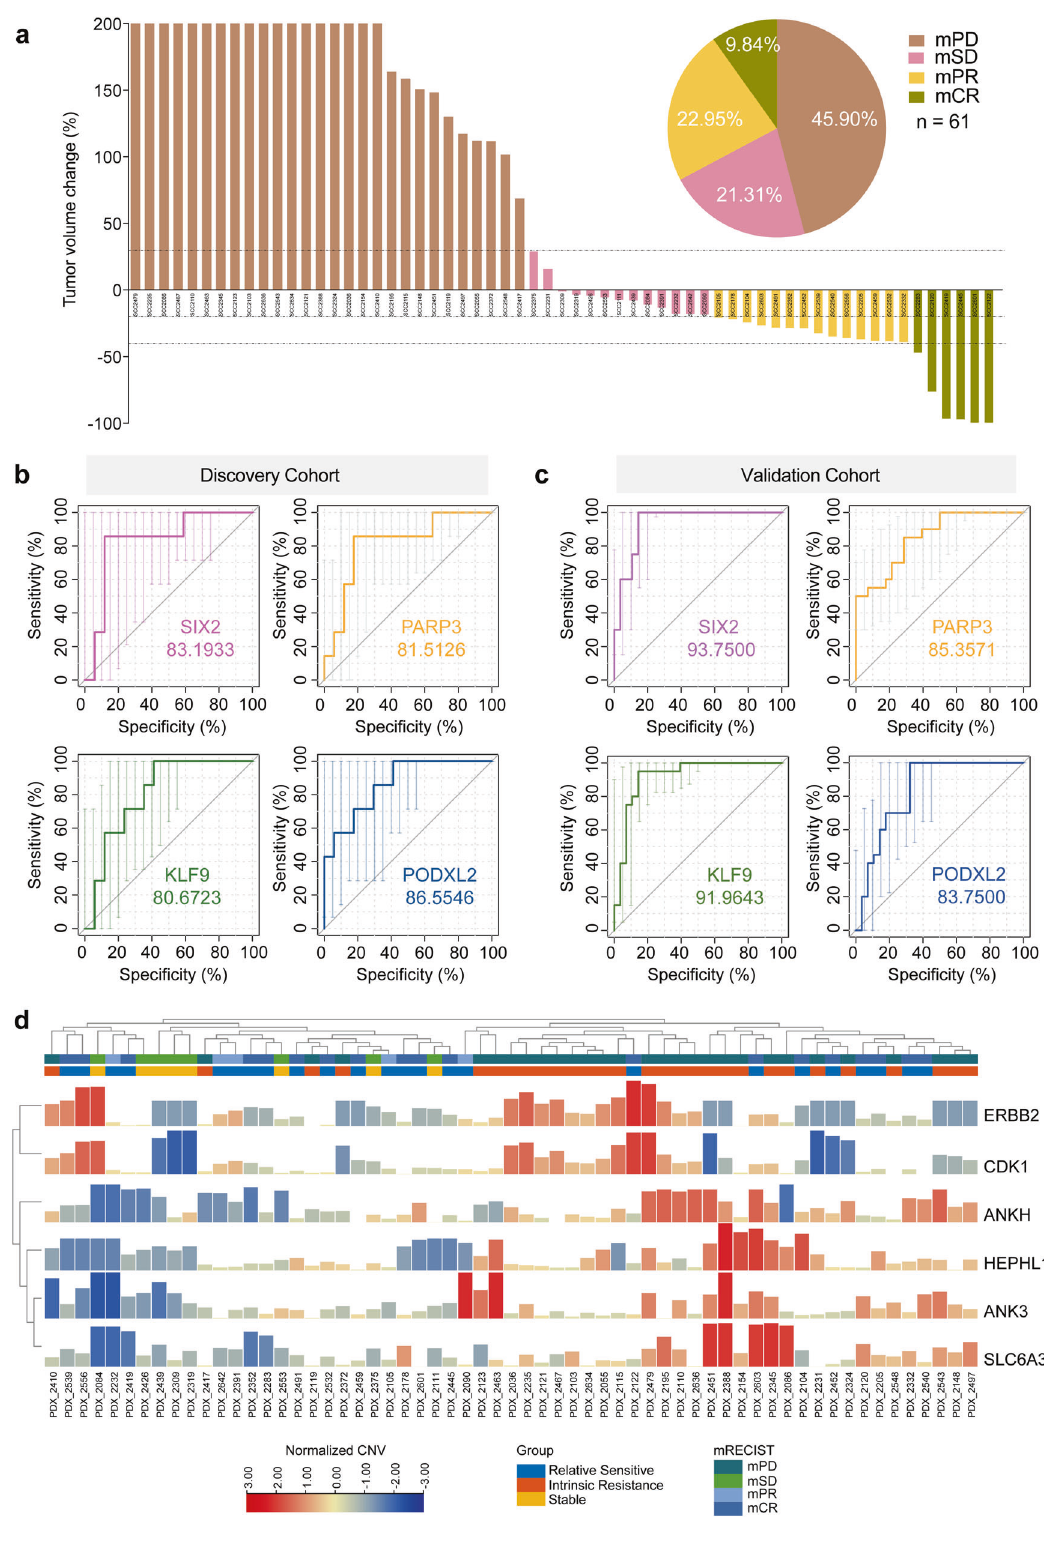
established the evolutionary classi fi cation of each mutation to distinguish events that were enriched or reduced in subclones that are dominant in the post-progression tumor (as compared with its pre-treatment counterpart). We identi fi ed multiple subclones (range 5 – 7) in the 6 cases and identi fi ed dynamic changes in clonal